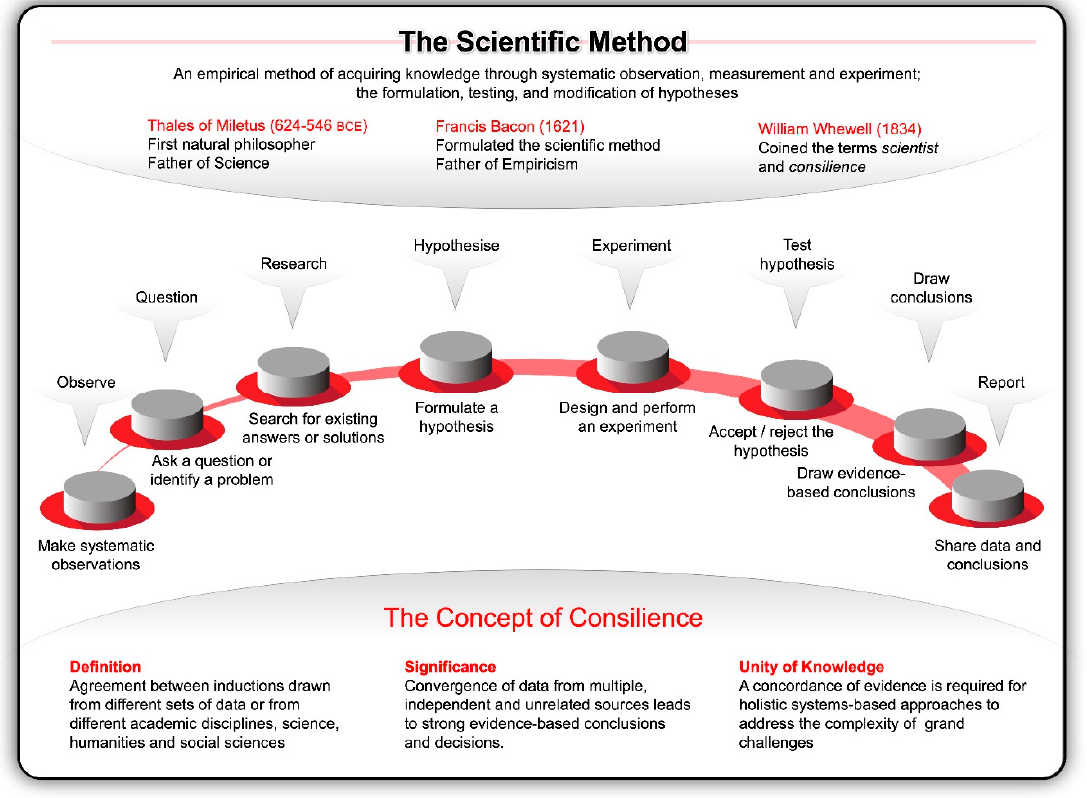
Figure 1. The scientific method, underpinned by the principles of consilience, was perhaps the single most important development in modern history. This approach entails systematic observation, measurement, and experiment, and the formulation, testing, and modification of hypotheses by drawing on data and evidence from independent, unrelated academic disciplines—from science, technology, engineering, mathematical, and medical (STEMM) fields of research to the humanities, arts, and social sciences